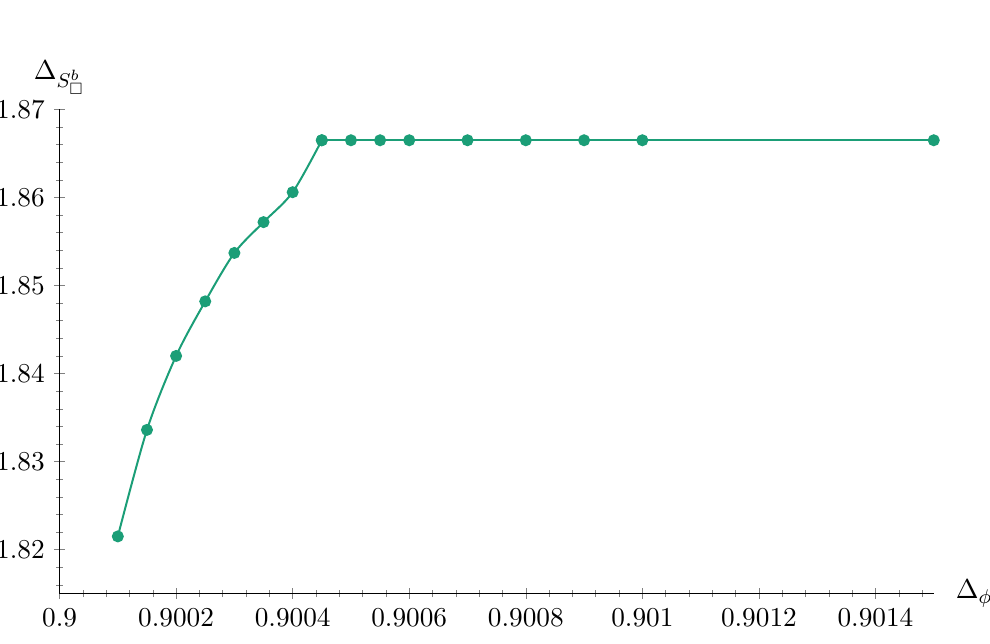
is equal to (cid:3)